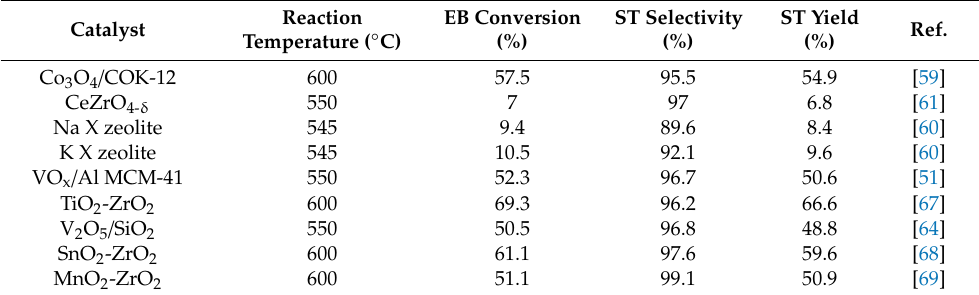
Table 7. Performance of CO 2 on oxidative dehydrogenation of ethylbenzene to